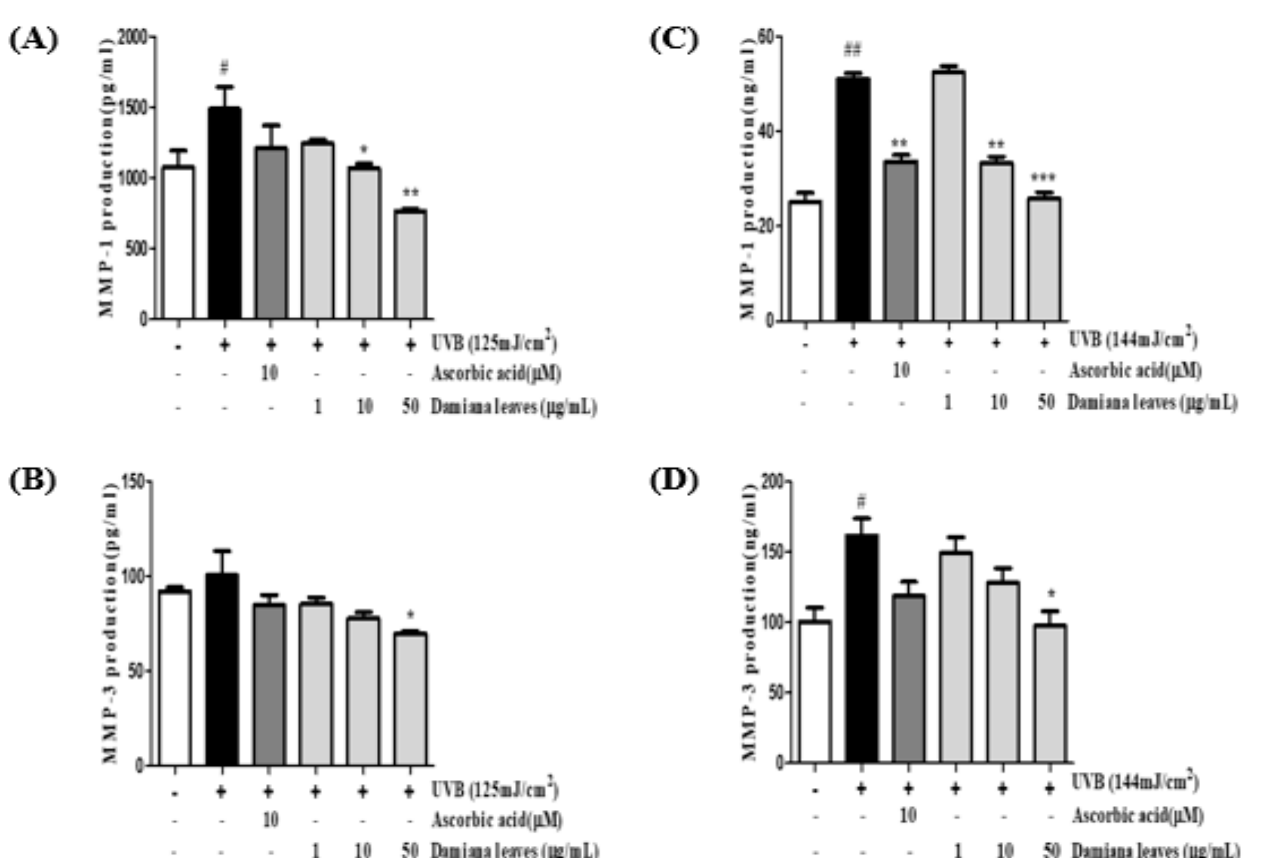
Figure 5. Effect of Damiana leaves extract on the protein secretion of MMP-1 and MMP-3 in UVB- irradiated HaCaT ( A , B ) and HDF ( C , D ) cells. Data are presented as the mean ± SD. # and * indicate significant differences from the non-irradiated control and UVB-treated groups, respectively. # and ## p < 0.05 and 0.01 vs. the non-treated group, respectively. *, ** and *** p < 0.05, 0.01, and 0.001 vs. the UVB-treated control, respectively.